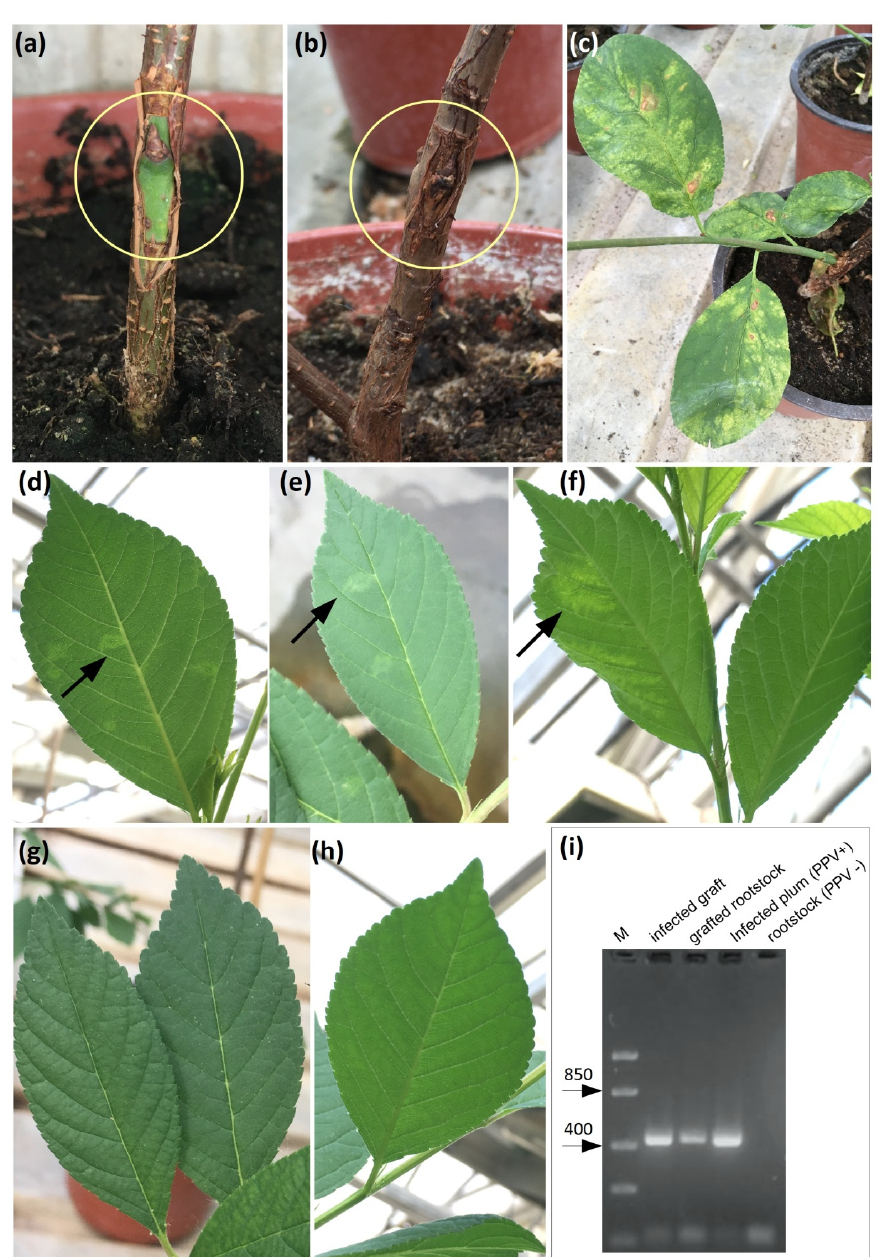
Figure 5. Infection of rootstock 146-2 plants with the Plum pox virus in a greenhouse and monitoring the development of the infection. ( a ) T-Budding of a plant of rootstock 146-2 with a plum bud infected with PPV (inside the yellow circle); ( b ) rootstock stem with bud after dormant stage (90 days at 6 degrees) (inside the yellow circle); ( c ) grafting on a rootstock showing signs of infection with a virus (PPV) developed from an infected bud during the first growing season; ( d , e , f ) signs of PPV infection on rootstock leaves after infection by grafting in the first year of vegetation; ( g , h ) leaves of rootstock 146-2, which was not infected with PPV; ( i ) detection PPV by RT-PCR analysis of RNA isolated from infected plum plants—virus donor (PPV+), infected graft, grafted rootstock, non-infected rootstock (PPV − ). Amplification of 442 bp fragment of PPV HC-Pro gene.